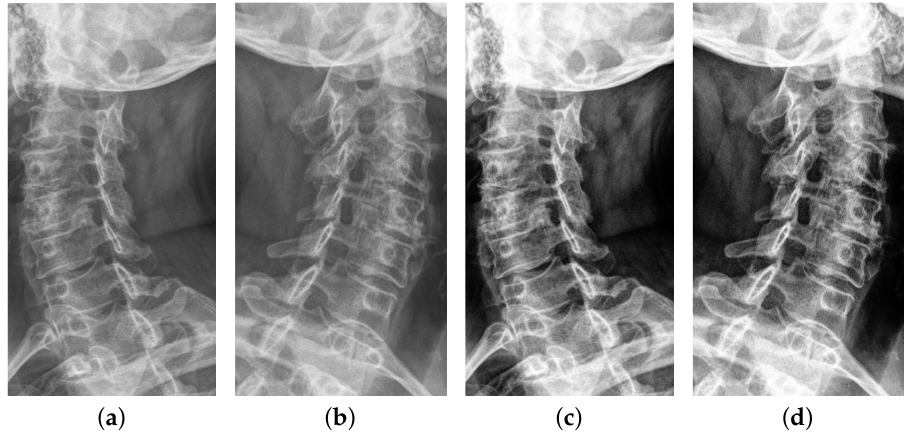
Figure 3. Results of Histogram Equalization. ( a ) right ROI cropped oblique view, ( b ) left ROI cropped oblique view, ( c ) right ROI cropped oblique view with HE applied, and ( d ) left ROI cropped oblique view with HE